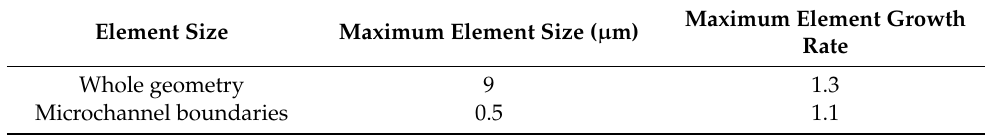
Figure 3. Grid system profiles: ( a ) unstructured triangular mesh, ( b ) comparison of the mixing efficiency for different grid systems. Table 2. Detailed parameters of element size in the grid system.